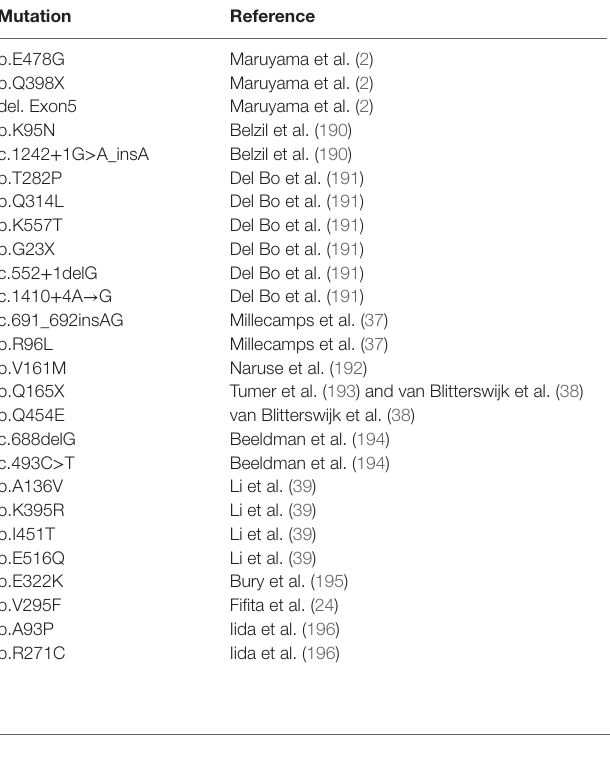
TAbLe 2 | ALS-associated mutations in OPTN